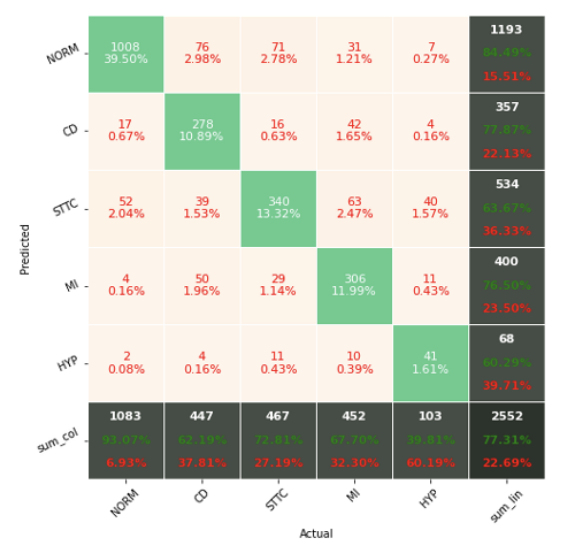
Figure 18. Confusion matrix of the best model in classification for 5